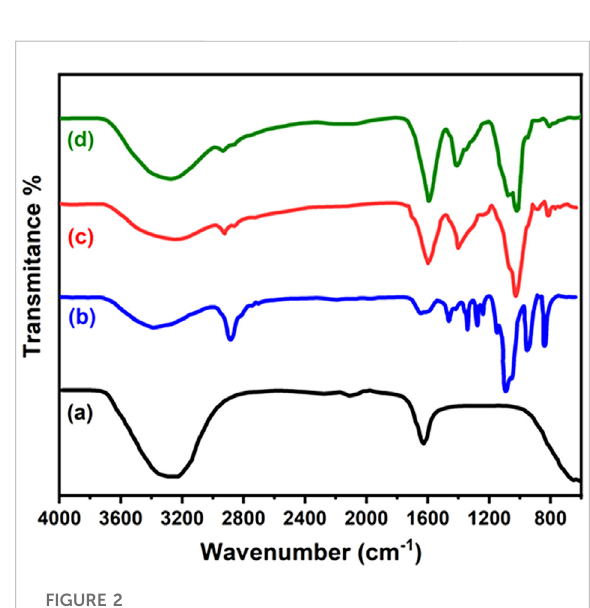
FIGURE 2 FTIR spectra of (A) pure neem leaf extract (B) alginate/ chitosan/PEO/neem extract composite (2%) (C) alginate/chitosan /PEO/neem extract composite (4%) (D) alginate/chitosan/PEO/ neem extract composite